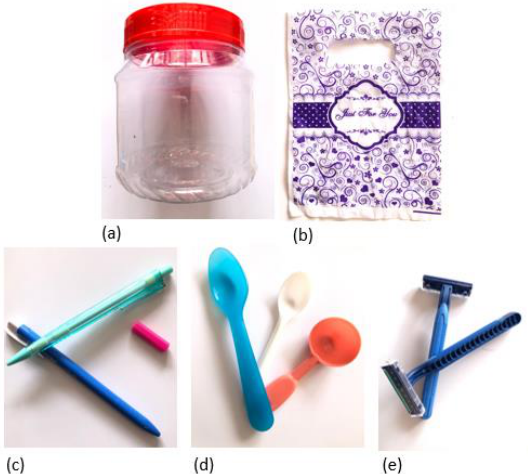
Figure 1. Biopolymer products: ( a ) food container, ( b ) plastic bag, ( c ) pens, ( d ) plastic spoon, and ( e ) shaving razor.